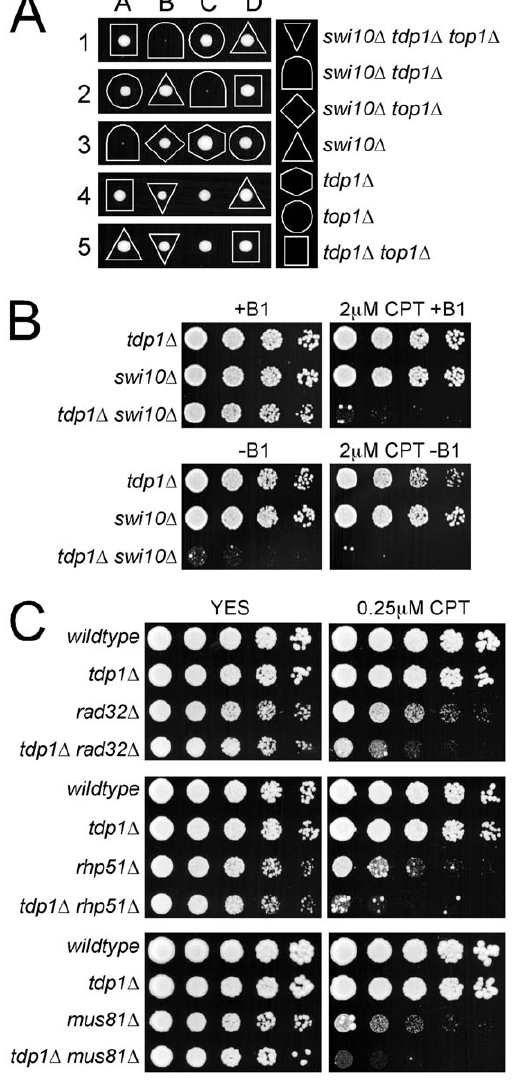
HR-dependent replication restart pathway [22].